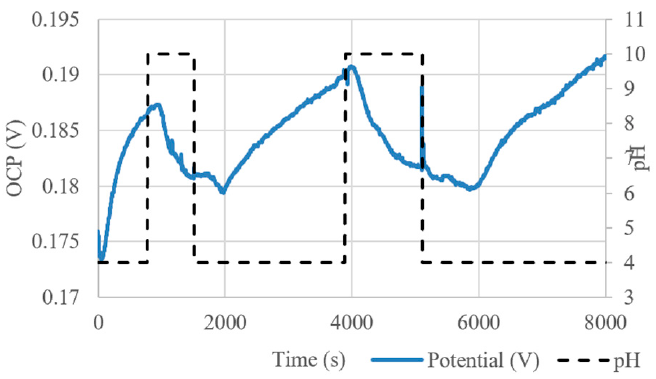
Figure 17. OCP response of embedded SPE (reproduced with permission from [24]).